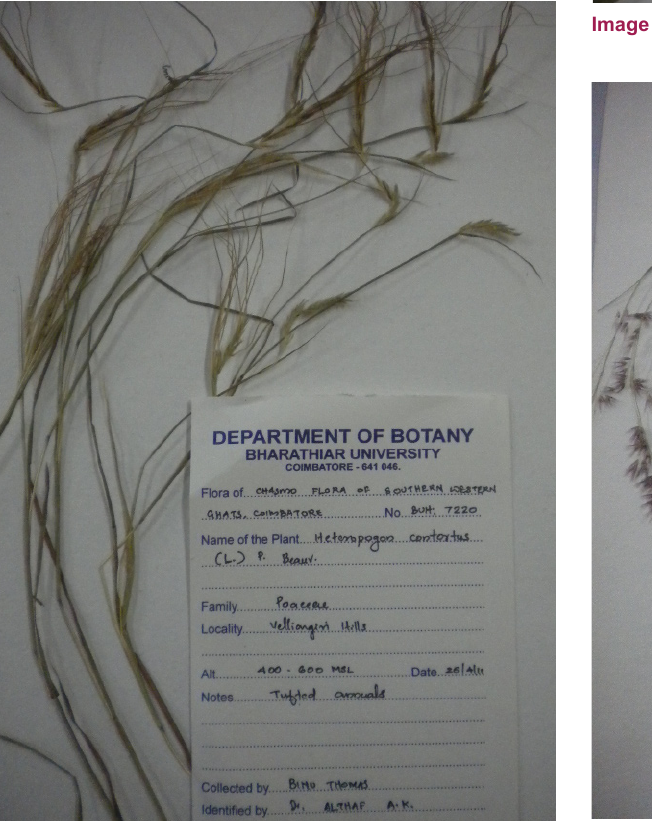
Image 22. Heteropogon contortus (L.) P. Beauv. Image 23. Melinis repens (Willd.)